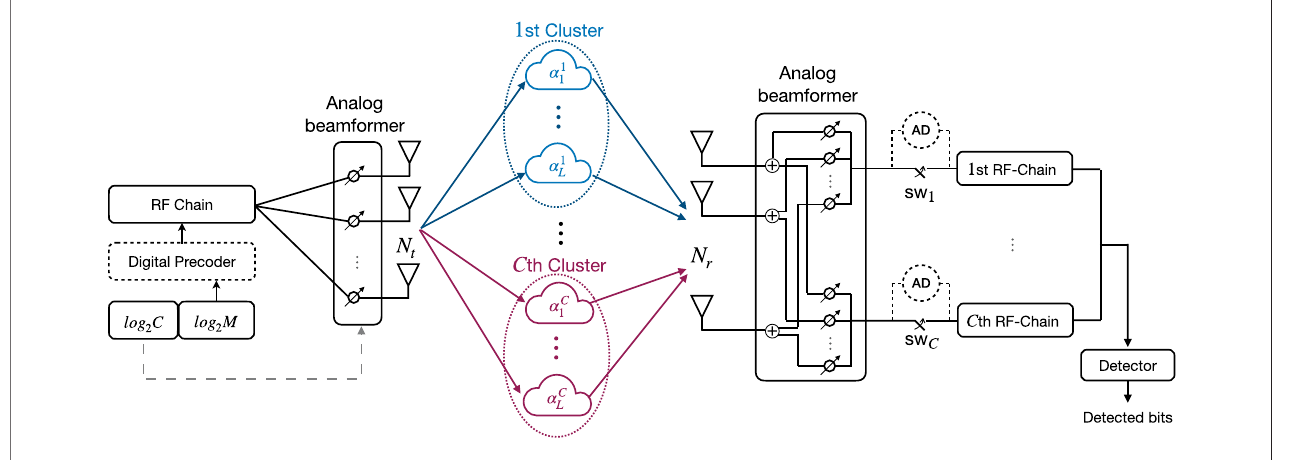
FIGURE 1 | CIM system model with analog and hybrid beamforming